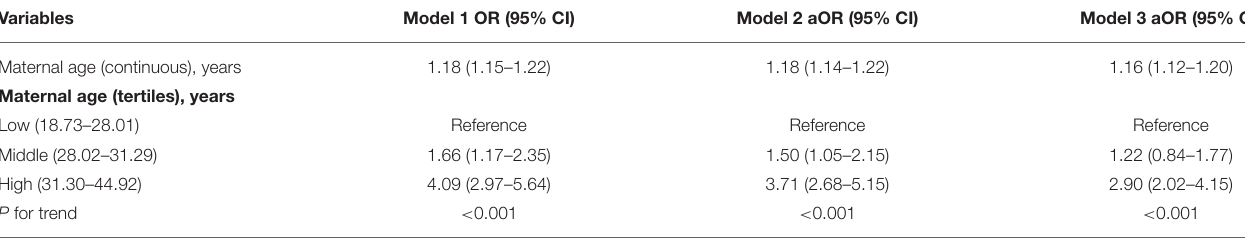
OR, odds ratio; CI, confidence interval; aOR, adjusted odds ratio. Model 1 adjusts for: none. Model 2 adjusts for: maternal ethnicity, maternal education, maternal occupation, and maternal income. Model 3 adjusts for: maternal ethnicity, maternal education, maternal occupation, maternal income, maternal body mass index, parity, folic acid supplementation, multivitamins supplementation, and medication use.